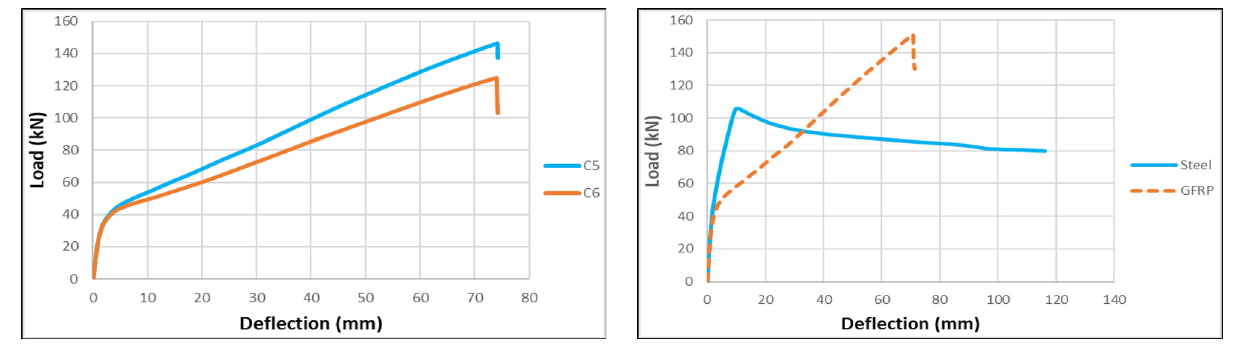
Figure 12: Load – de fl ection curve for specimens beams C5 and C6.